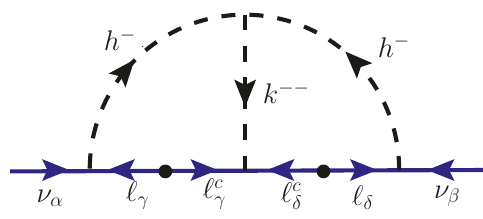
Figure 43 . Neutrino mass generation at two-loop in the Zee-Babu model [15, 16]. This model generates operator of eq. O 9